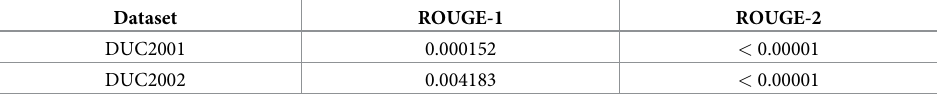
Table 9. The p-values obtained by Approach-1 (WMD) with SOM based operators (under SMaxRouge scheme) considering ROUGE-1 and ROUGE-2 score